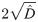
Magnitudes of source and target effects.Connections weights may be modulated properties of their end points, modeled here as source δ and target ε effects. A positive effect δi or εi means an increased likelihood of a connection originating from or terminating at node i, respectively. The effects have been scaled to percentages of the maximum latent distance (2D^) for easier interpretation.